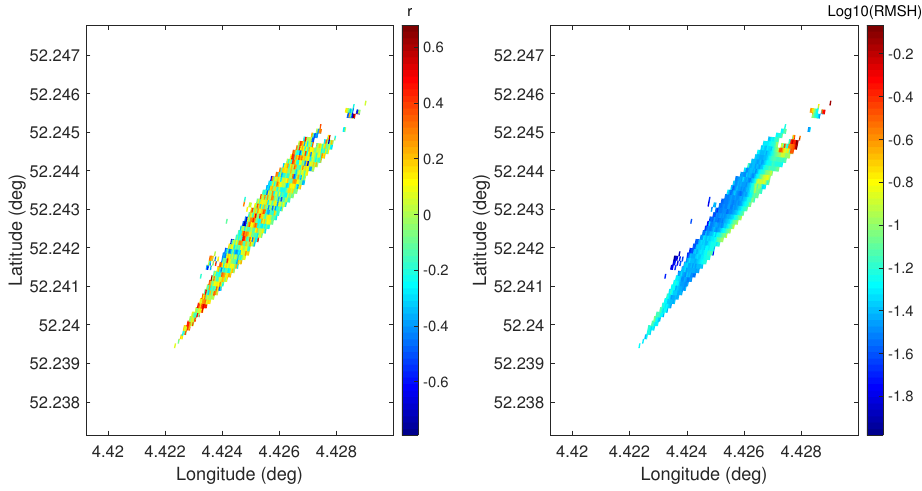
( A ) for each pixel of the study area 10